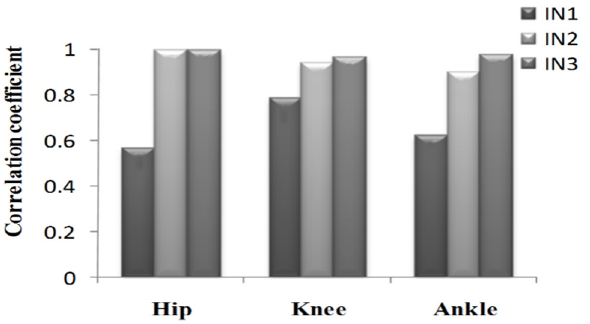
Figure 21. Correlation coefficient of the prediction results in the going upstairs process.